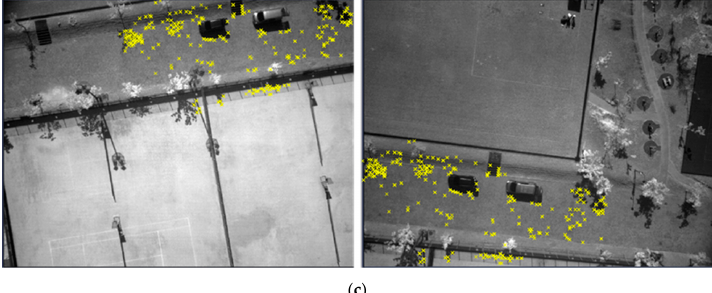
Figure 15. An example of accepted tie points for ( a ) red, ( b ) red-edge, and ( c ) NIR bands.